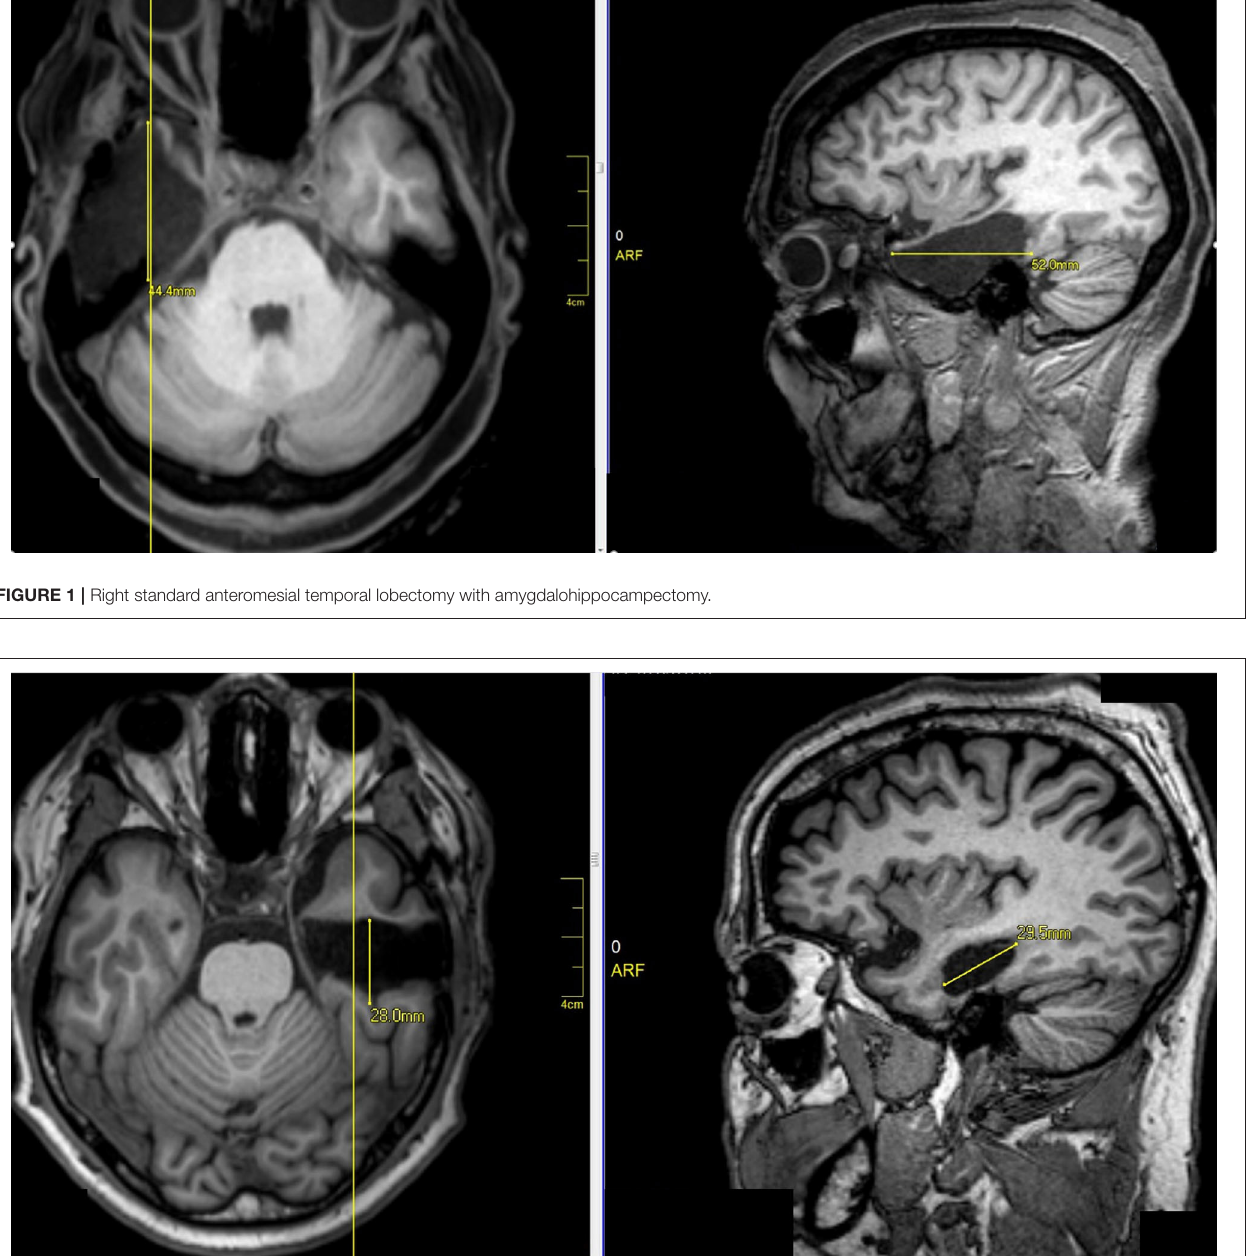
with a p < 0.2 in the univariate analysis and the final model p - value under 0.05. Our goal was to assess the variables that could predict surgical outcomes and create a model that we can apply to new similar cases in the future, thus being able to explain